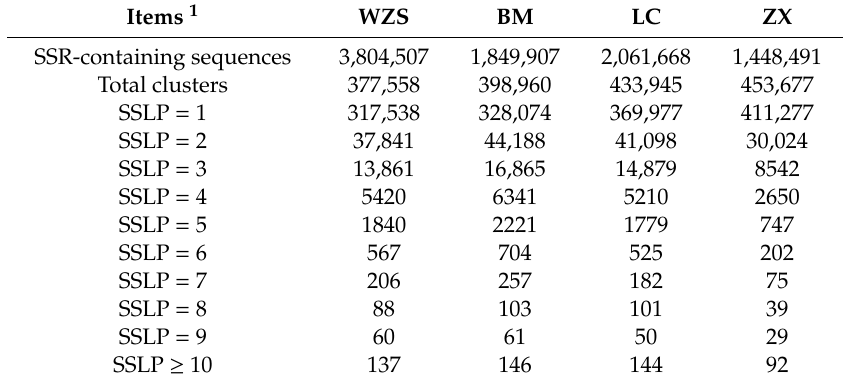
Table 2. SSR length polymorphisms (SSLPs) and corresponding number of SSRs in four pig breeds.